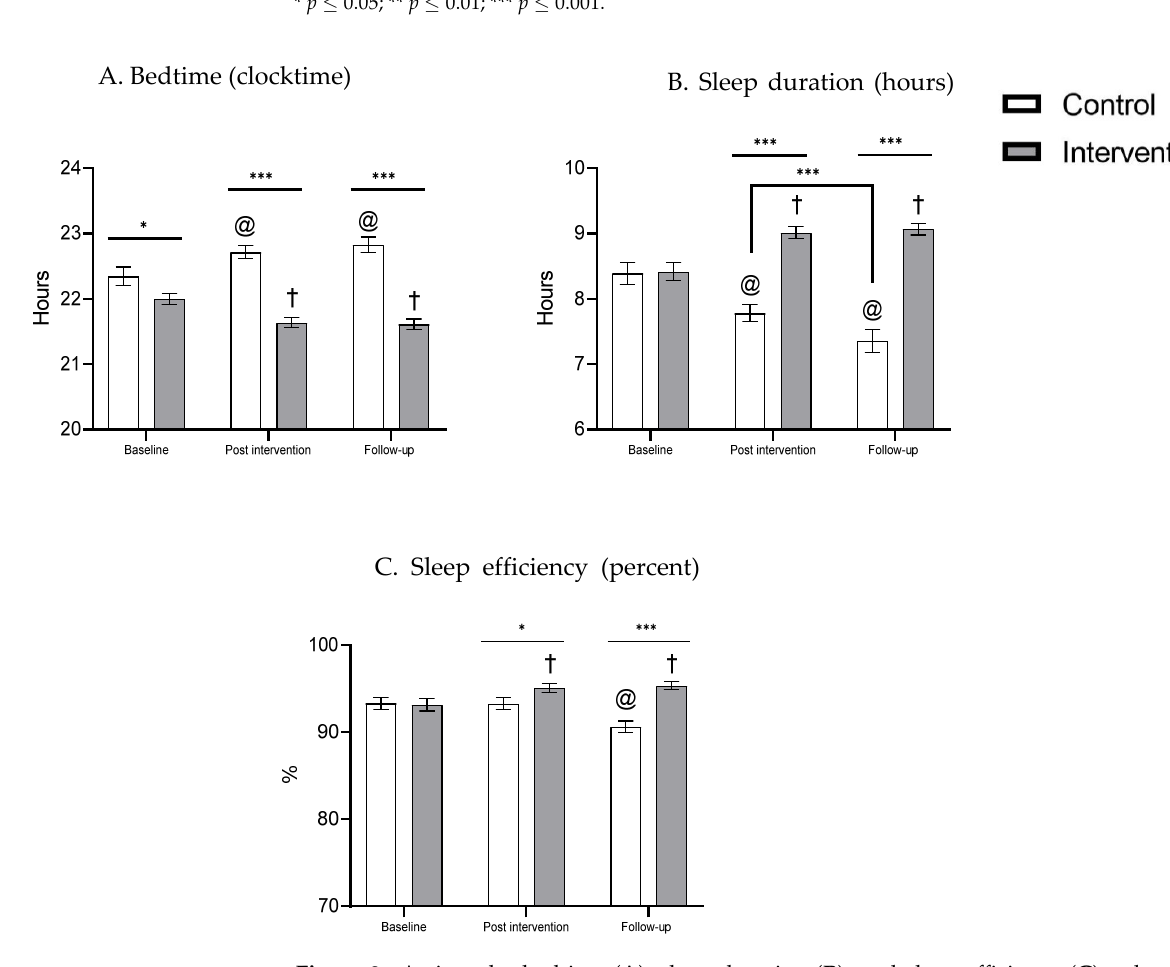
Figure 2. Actigraphy bedtime ( A ), sleep duration ( B ), and sleep efficiency ( C ) at baseline, post- intervention and follow-up, intervention and control groups. * p < 0.05, *** p < 0.001, † different from intervention baseline, @ different from control baseline. Bedtime: A significant main effect was found for group [F(1, 66) = 54.53, p < 0.001], so that the intervention group went to bed earlier than the control group. While there was